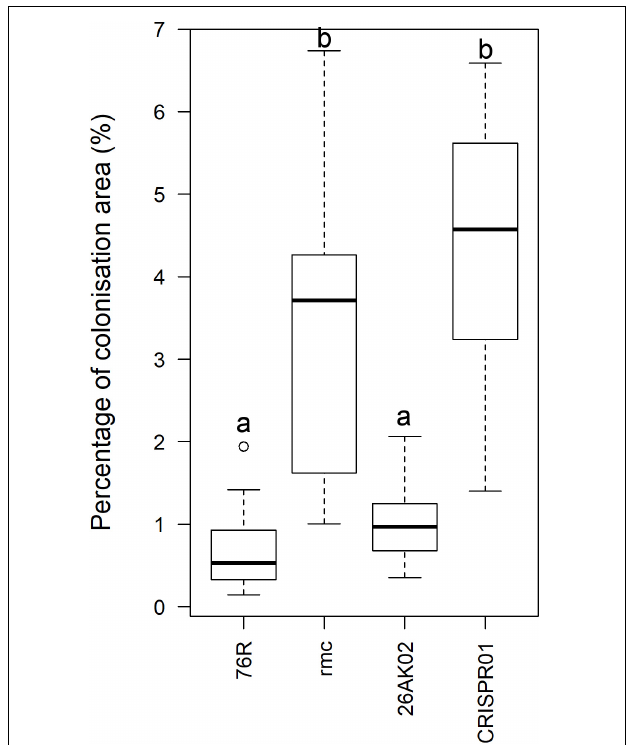
FIGURE 5 | Quantitative analysis of intensity of root colonization by Fusarium oxysporum f. sp. lycopersici ( Fol ) race 3 observed by phase-contrast microscopy at 24 h after inoculation. Quantitative analysis was performed using ImageJ (Schindelin et al., 2012). Intensity of colonization was measured as area of mycelia against the total area of image. Image quantification was based on gray levels of 8-bit images. Box plot indicated by the same letters are not significantly different ( P <